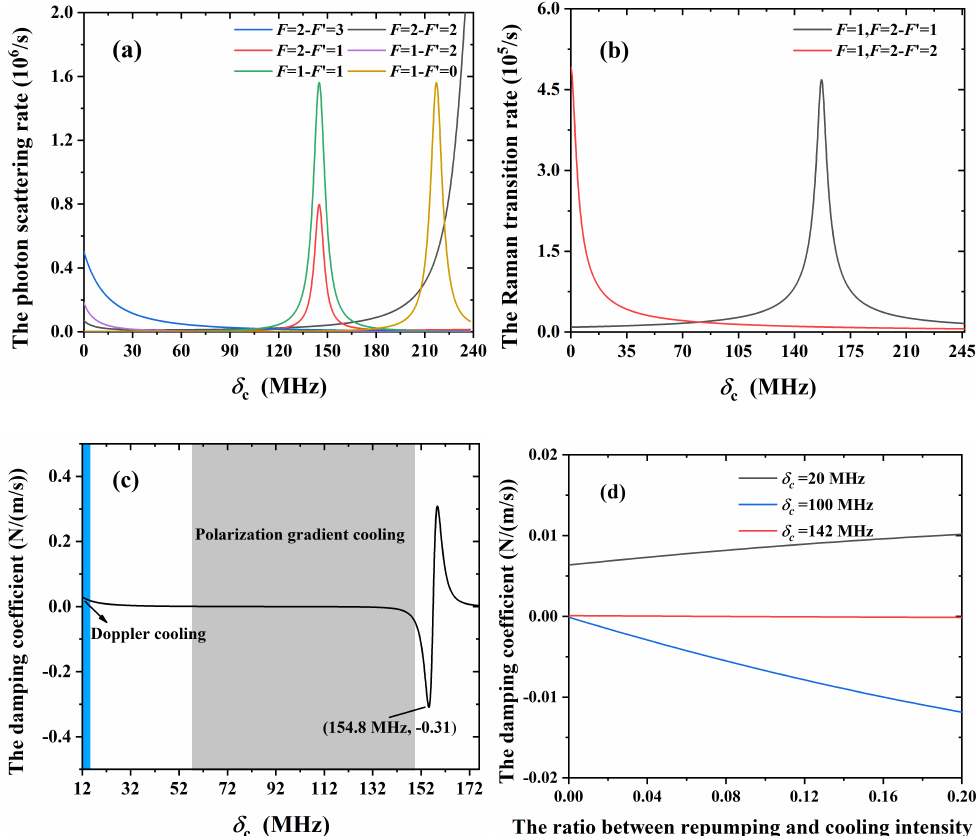
Figure 2. Simulations of the effect of laser beams on atoms during the stage of cooling: ( a ) The relationship between the photon scattering rate and frequency shifts (calculated with Equation (1)); ( b ) the changes of the Raman transition rate with frequency shifts (calculated with the Equation (3)); ( c ) the variety of damping coefficients with frequency shifts (calculated with the Equation (2)); and ( d ) the relationship of the intensity ratio and the damping coefficient (calculated with the Equation